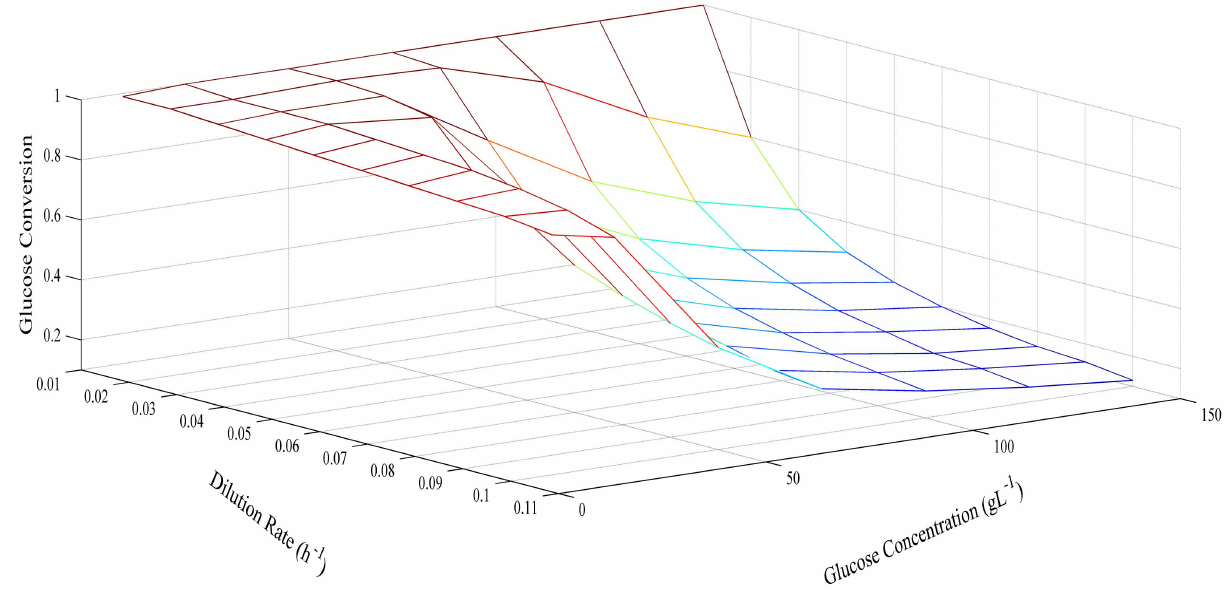
Figure 8. Simulated effects of dilution rate and glucose concentration on glucose conversion rate. Color differences indicate